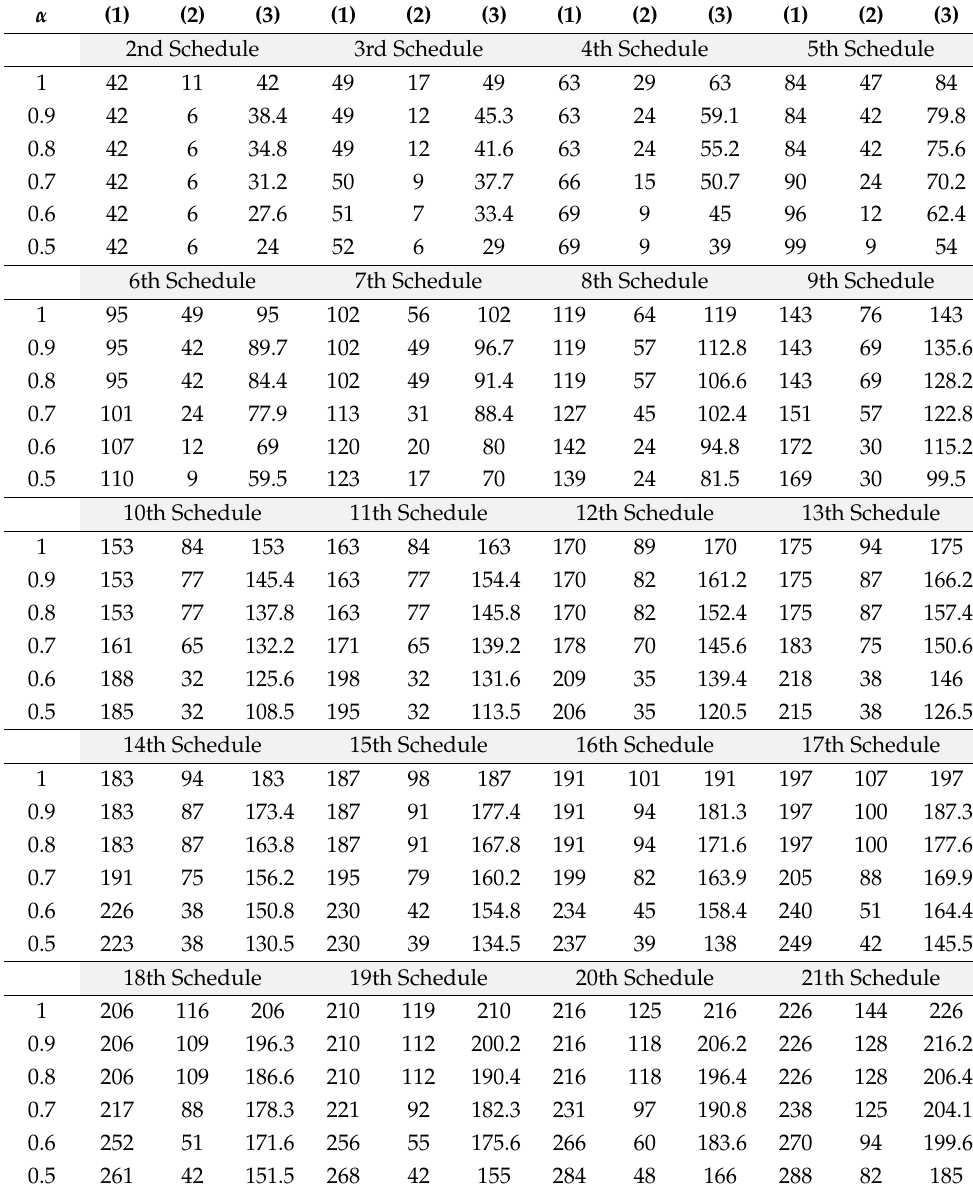
Table 7. Influence of α on the optimal